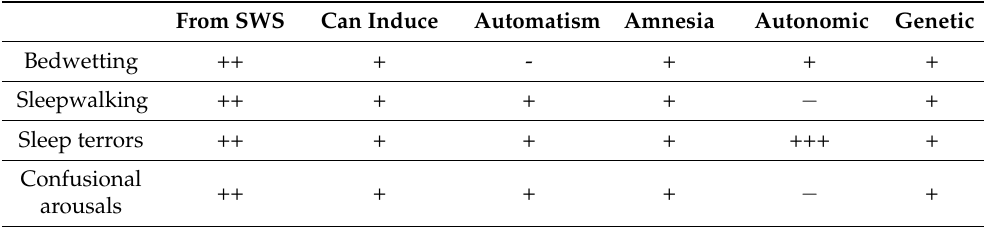
Table 1. A comparison of the features of four parasomnias associated with arousals. From SWS Can Induce Automatism Amnesia Autonomic Genetic Bedwetting ++ + - + + + Sleepwalking ++